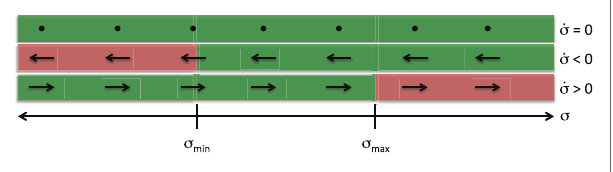
FIGURE 2 | Graphic illustration of the function in_T_RC with return value True shown in green and False in red . The function only returns False when (cid:27) is outside or on the border of its valid set and the derivative points away from the valid